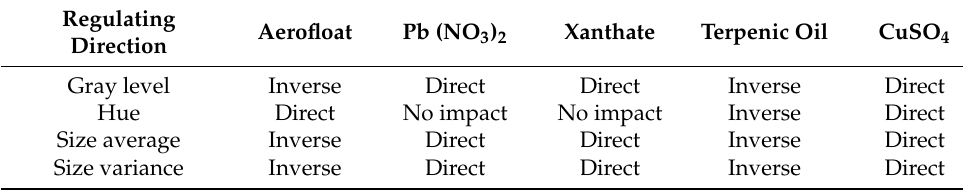
Table 6. The relationship between a single froth feature with each reagent.